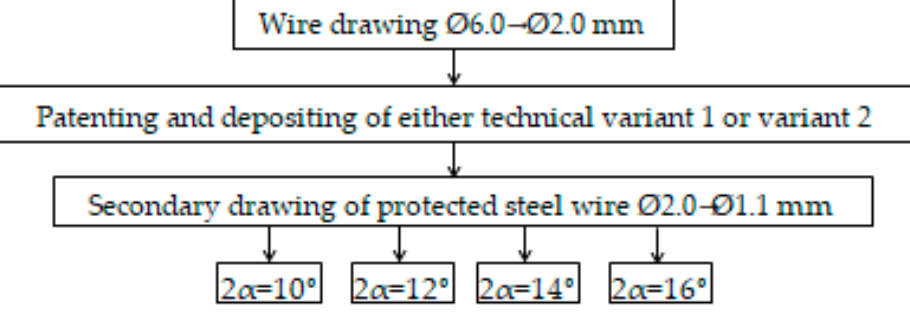
Figure 1. Technical flow with stages of experimentation.